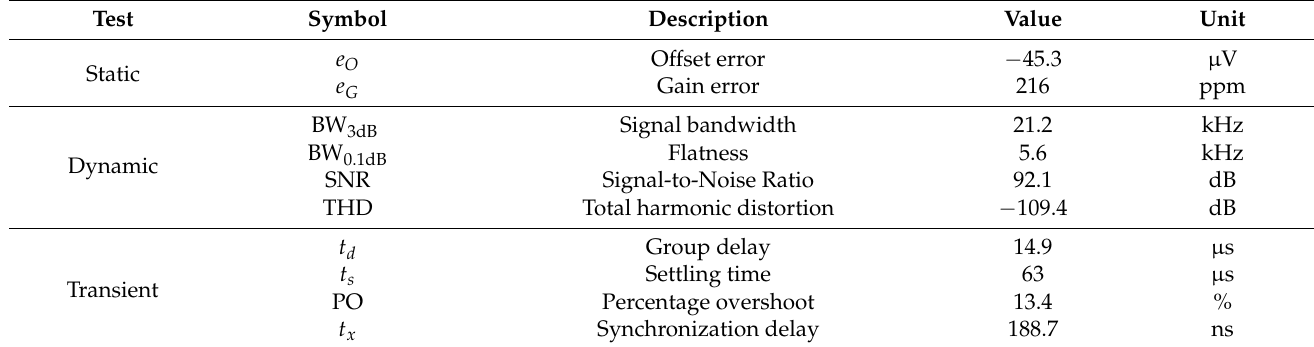
Table 1. SMU performance characterization